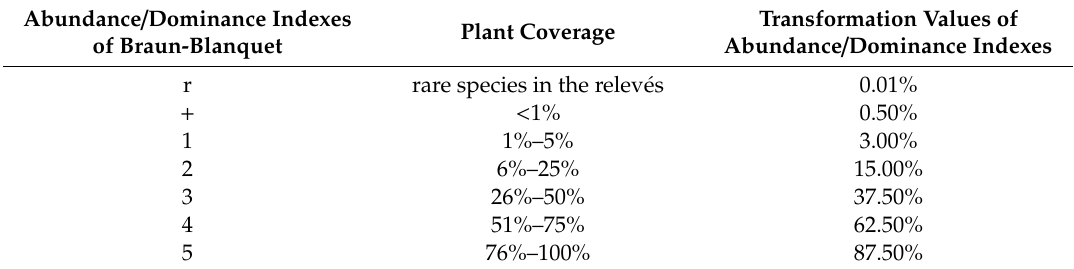
Table 1. Meaning of the abundance / dominance indexes of Braun-Blanquet [40] and transformation values proposed by